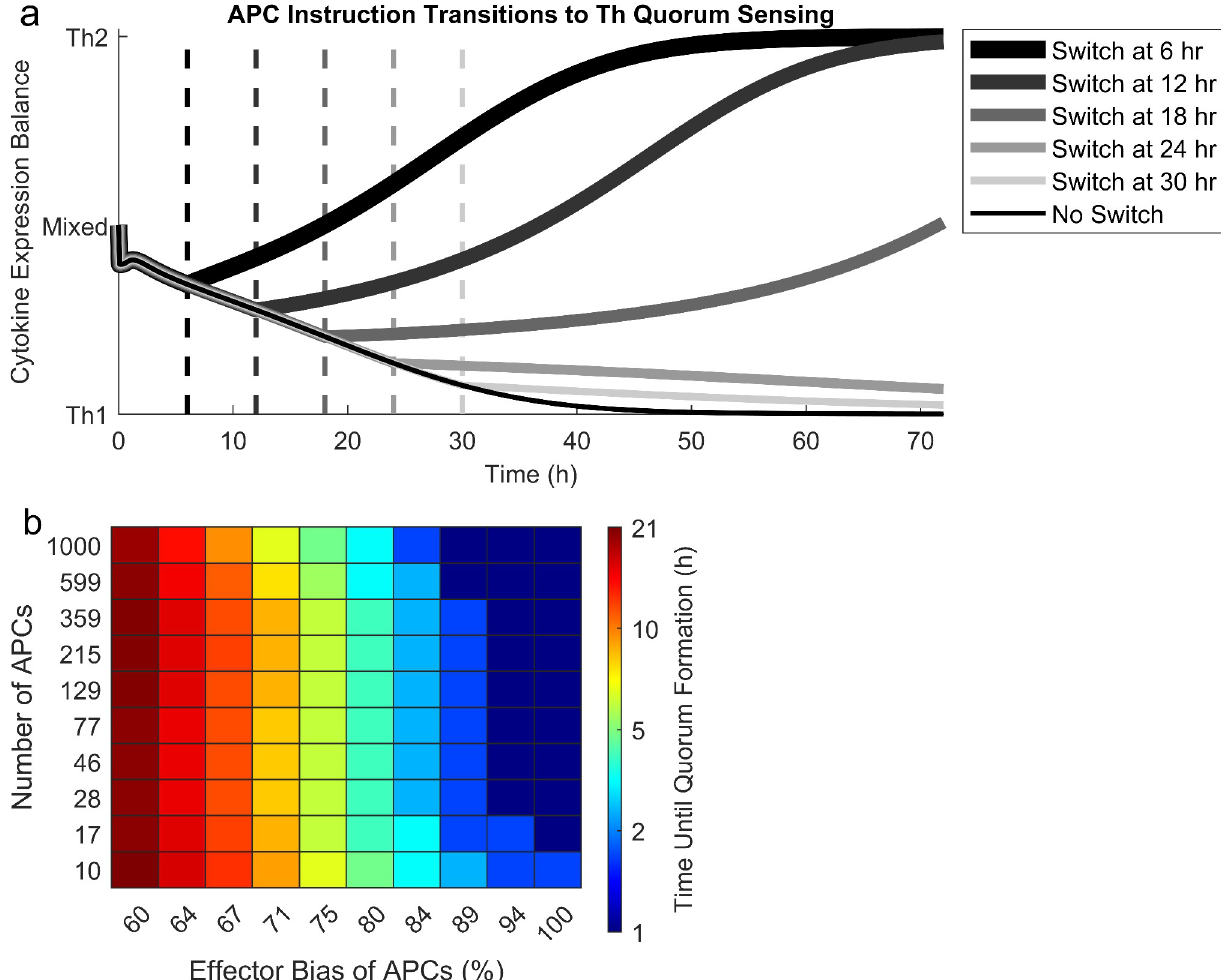
Even this small Th1 bias among APCs sparks a Th1-committed Th cell quorum. At some time marked by the grayscale dashed lines, the number of APCs increases to 1000, all instructing for Th2. This drastic switch can only reverse the commitment of the Th quorum if it occurs soon after initial arrival of APCs in the lymph node (here ~20 hr). (b) The time required for Th quorum commitment to become irreversible is most strongly controlled by the initial APC effector bias–the higher the percentage of APCs in favor of one effector type, the sooner the resulting Th quorum becomes irreversible. Timing is also impacted by the initial number of APCs–the larger the number of APCs, the sooner the resulting Th quorum becomes